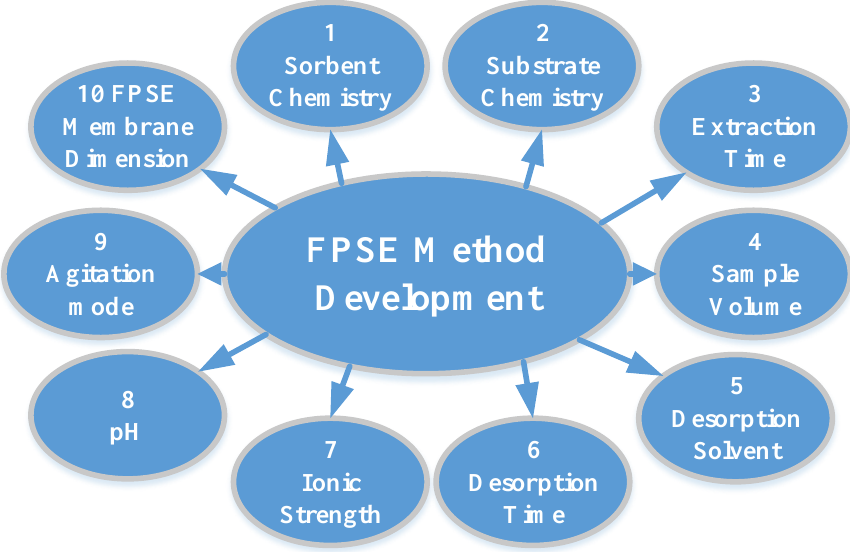
Figure 2. Factors and their relative importance on fabric phase sorptive extraction method devel-